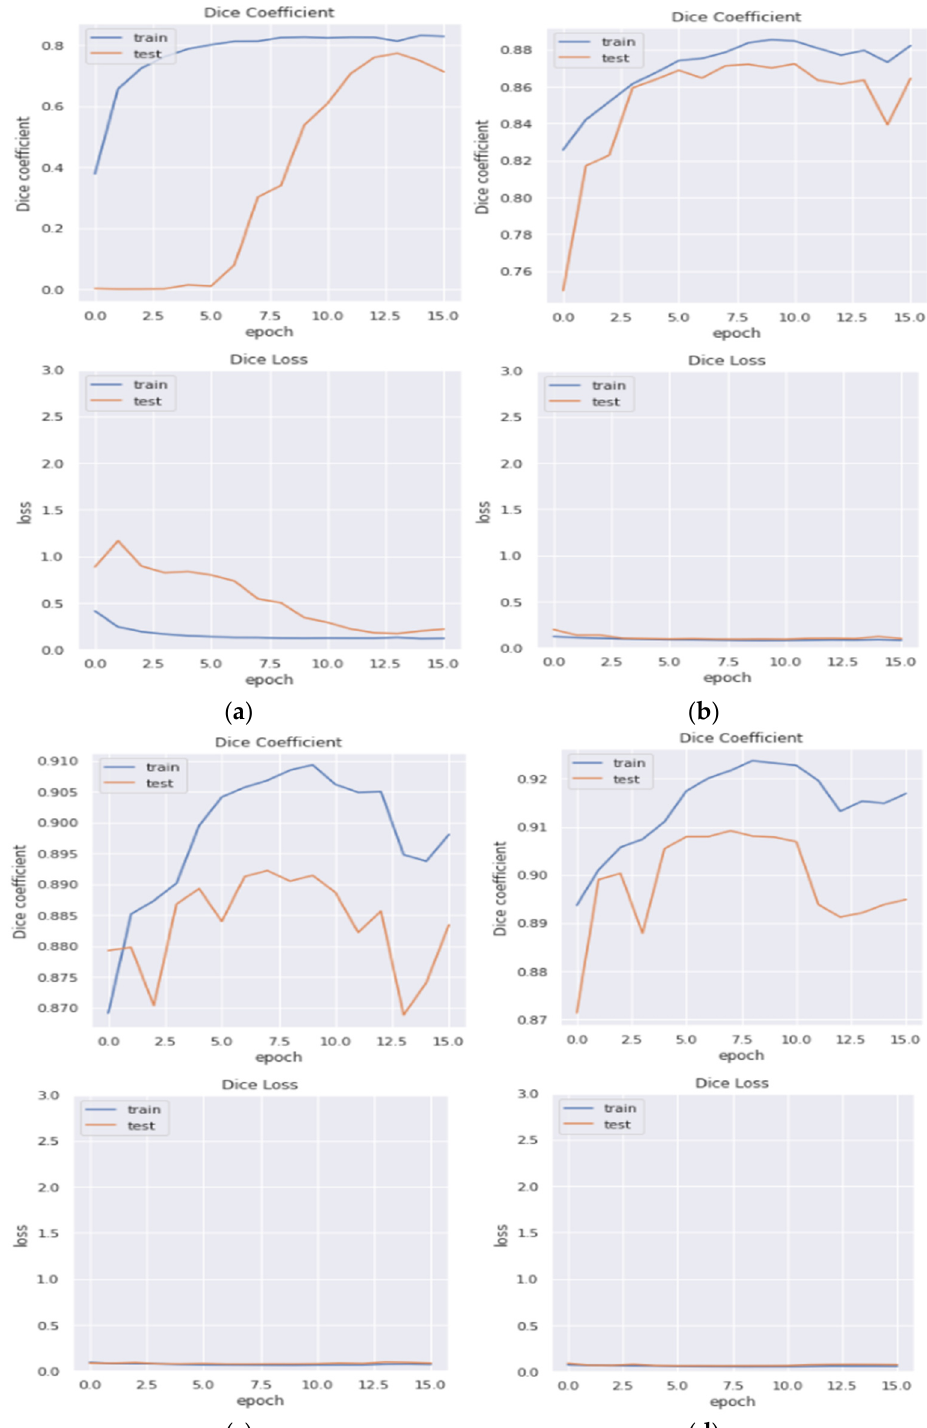
Figure 10. ( a ) Dice Coefficient and Dice Loss Training curves of the infection segmentation model using fold 1. ( b ) Dice Coefficient and Dice Loss Training curves of the infection segmentation model using fold 2. ( c ) Dice Coefficient and Dice Loss Training curves of the infection segmentation model using fold 3. ( d ) Dice Coefficient and Dice Loss Training curves of the infection segmentation model using fold 4. The curves clearly confirm the good performance of the proposed model on unseen data in the different folds, as the training and validation loss decreased to a point of sta- bility. Figure 11 demonstrates the Loss Training curve of the classification model.